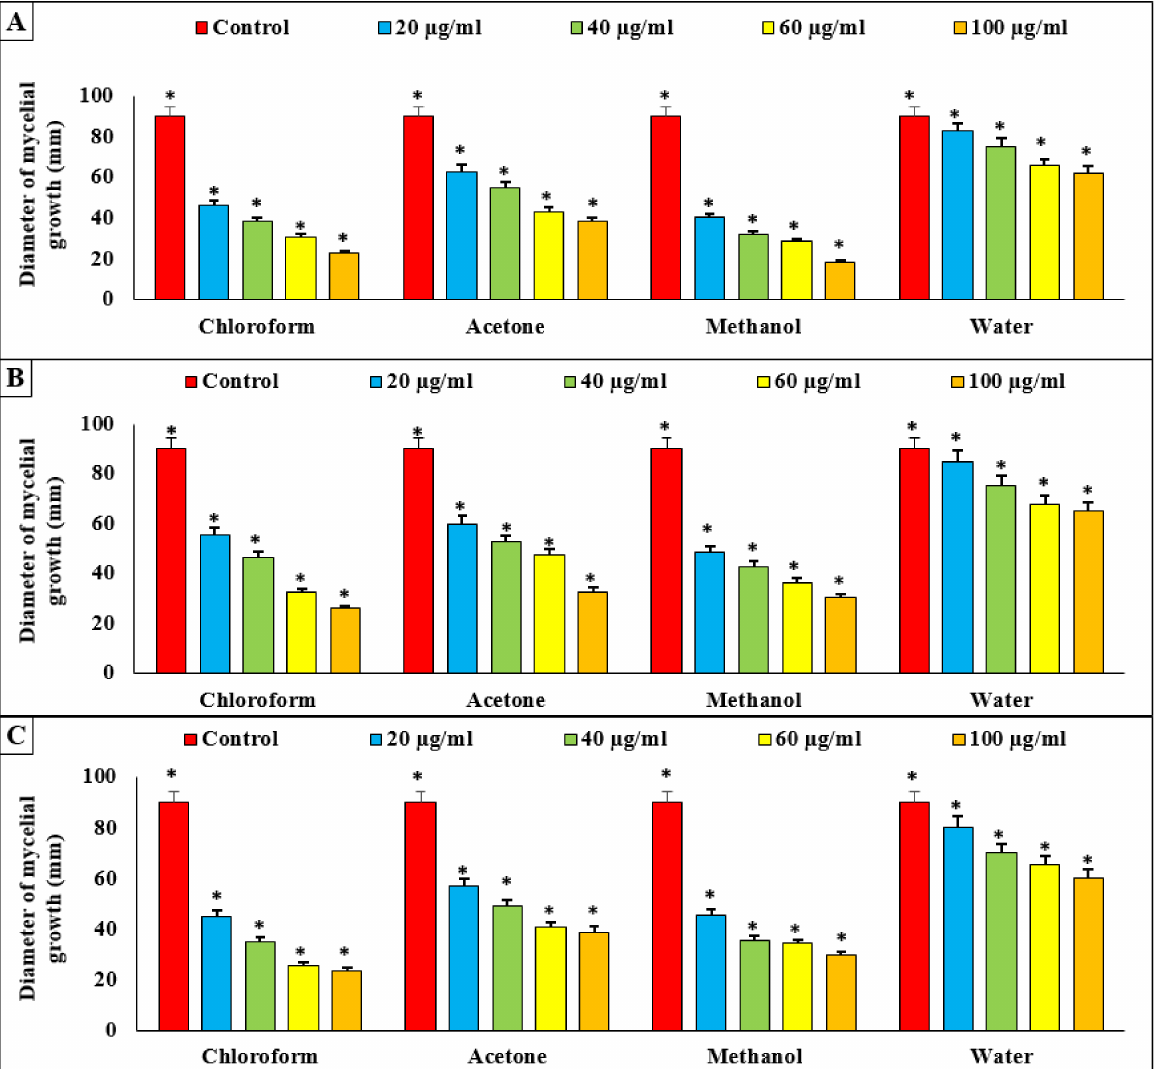
Figure 4. Effect of S. dentifolium ; ( A ), G. compressa ; ( B ) and U. lactuca ; ( C ) extracts of different solvents on the mycelial fungal growth of FOL on PDA medium (highly significant = * p < 0.05, n =